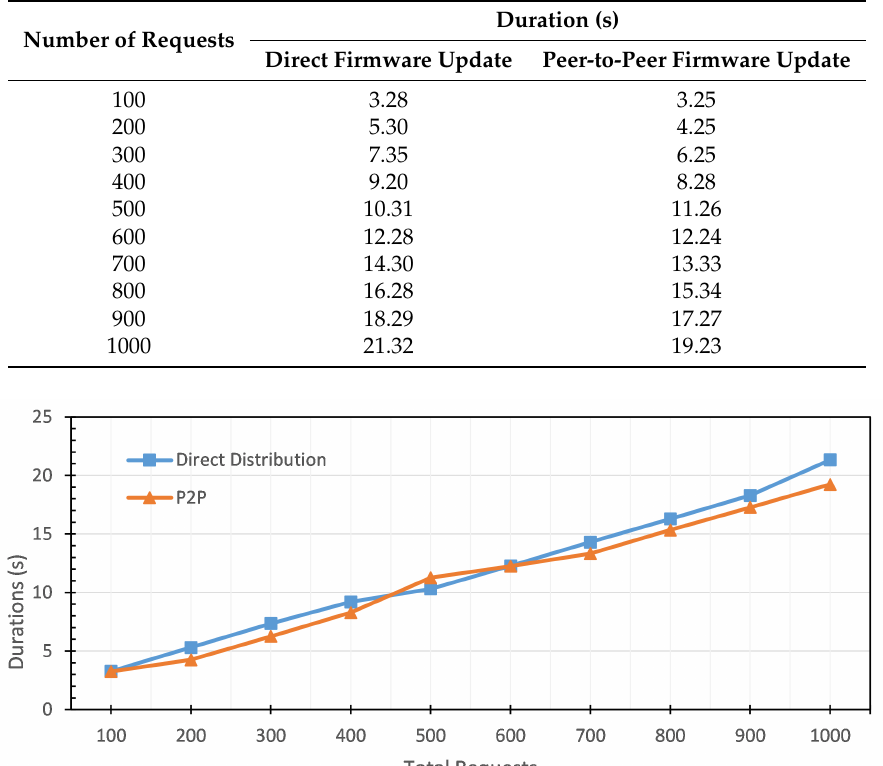
Table 5. Direct firmware update and peer-to-peer firmware update: the results of duration for the Download Update step.